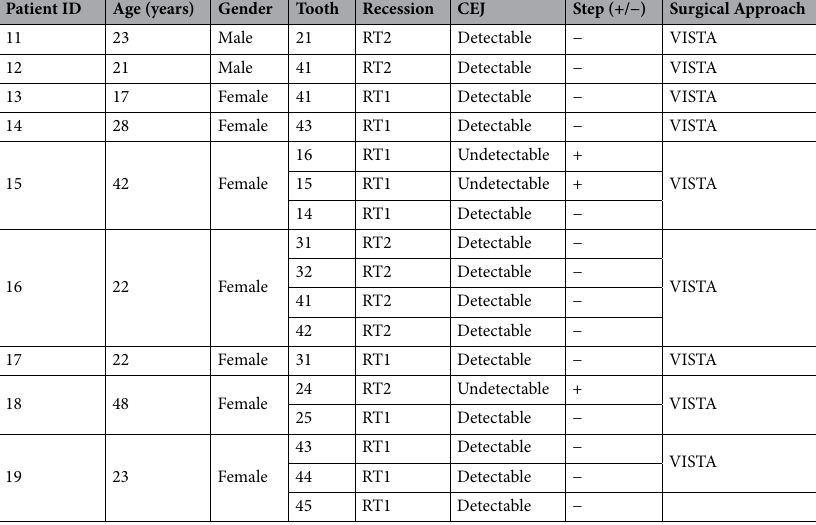
Table 2. Gingival recession characteristics.